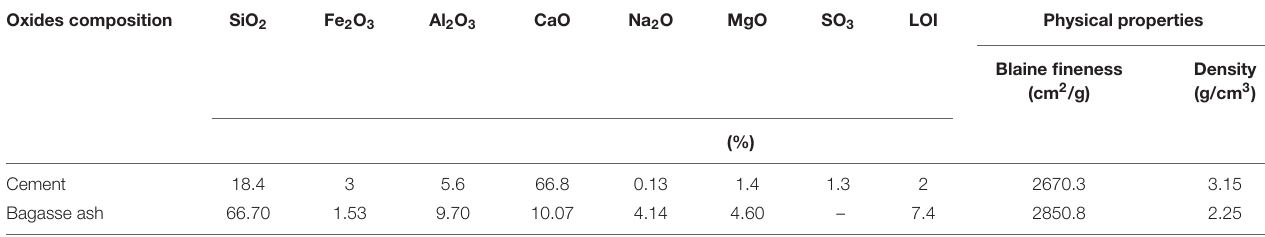
TABLE 1 | Chemical composition of cement and bagasse ash.